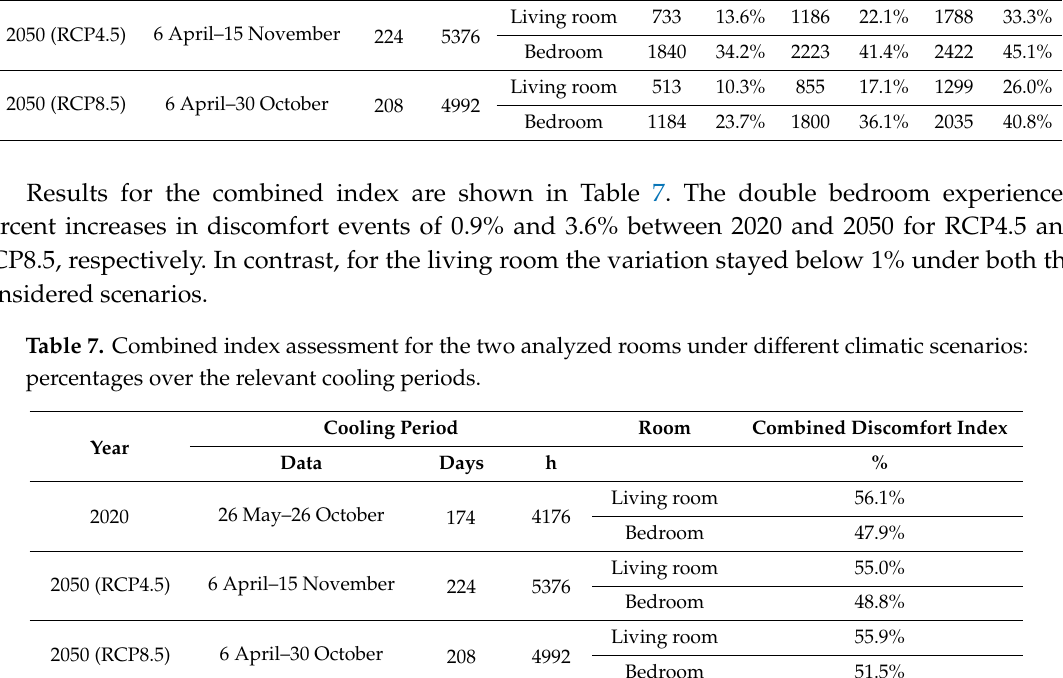
Table 7. Combined index assessment for the two analyzed rooms under different climatic scenarios: percentages over the relevant cooling periods .